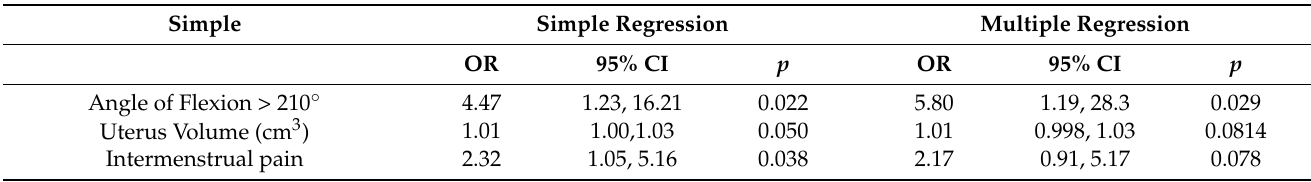
Table 2. Simple and multiple logistic regression analyses between presence of adenomyosis and related factors. No significant relation was observed with age, BMI, parity, abortion, age at menar- che, previous surgery, heavy menstrual bleeding, menstrual pain, pain at intercourse, endometrio- sis, myomas or hormone therapy.